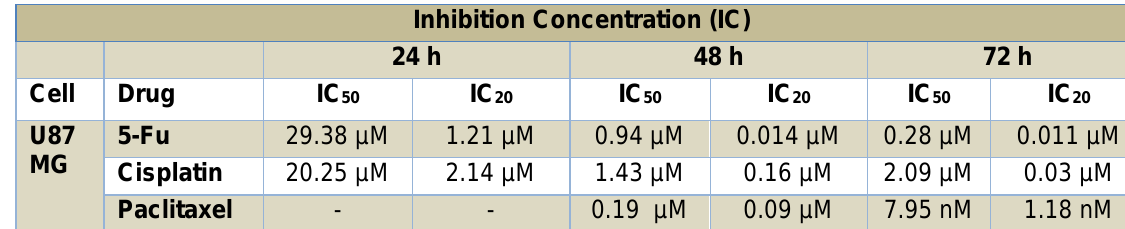
Table 1: Inhibition concentrations (IC 50 and IC 20 ) in U87 MG cells treated for 24, 48, and 72 h with 5- fluorouracil, cisplatin, and paclitaxel at nine different doses (obtained by serial dilution from stock con- centrations of 1000 µM, 200 µM, and 500 nM, respectively). Values were calculated from MTT data using the probit analysis function of